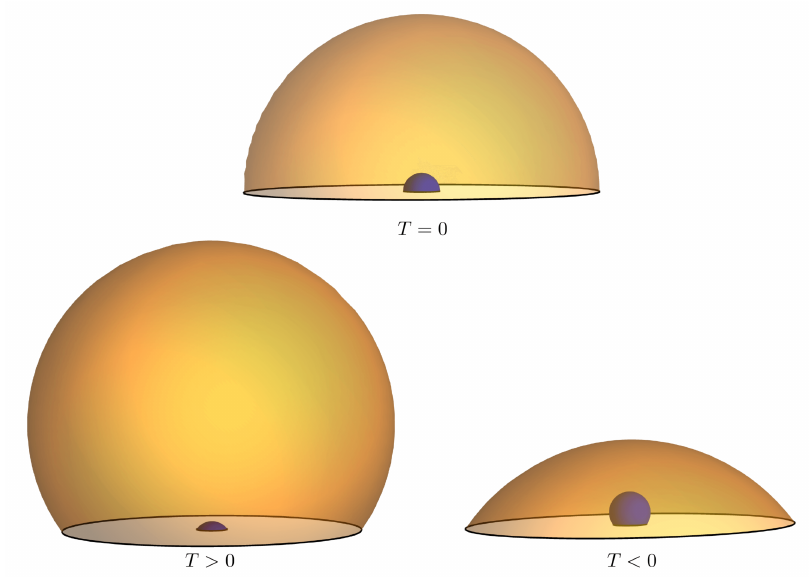
Figure 24 . Bulk domain for the BTZ phase in Poincaré coordinates. For zero tension the domain is given by the region in between two concentric hemispheres of radii r = e − h (left BTZ brane) and in r out = 1 (right BTZ brane). The addition of positive (negative) tension causes the bulk domain to enlarge (shrink): both radii increase, but the center of the inner sphere shifts to negative (positive) values of η , while the center of the outer sphere shifts to positive (negative) values of η